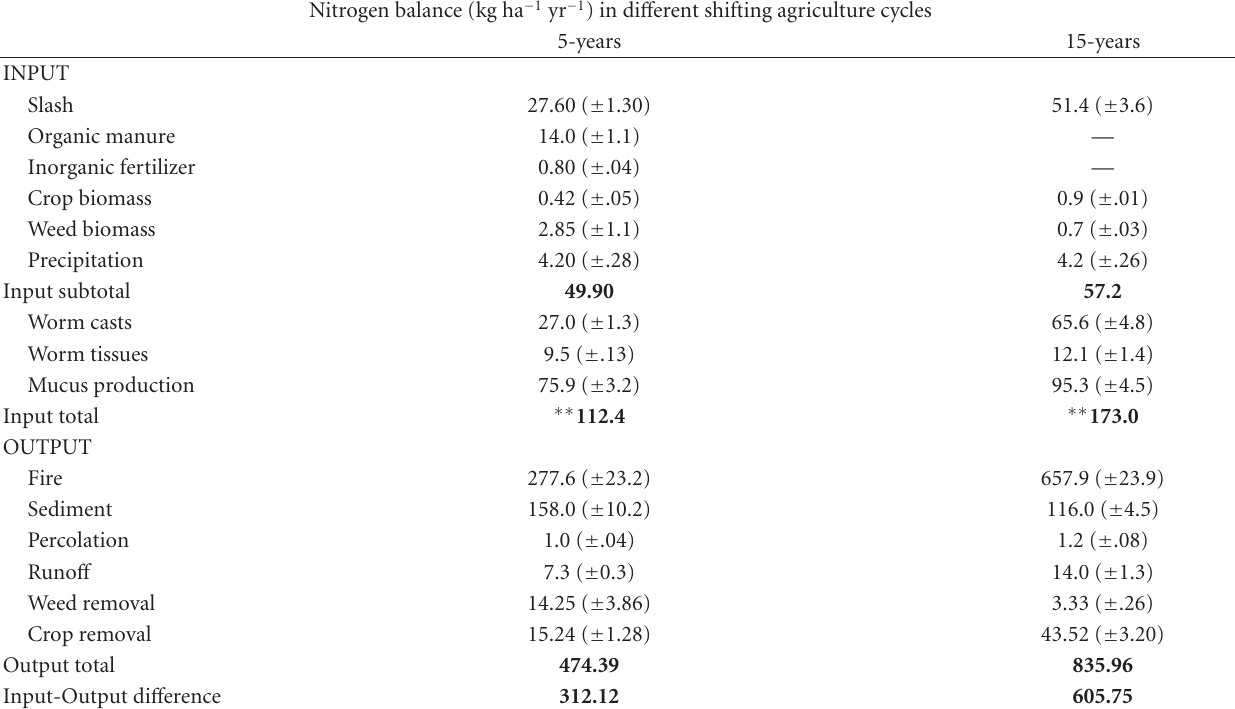
Table 7: Nitrogen input/output budget during the cropping phase under 5- and 15-year Jhum cycle, ( ± SE, n = 5)